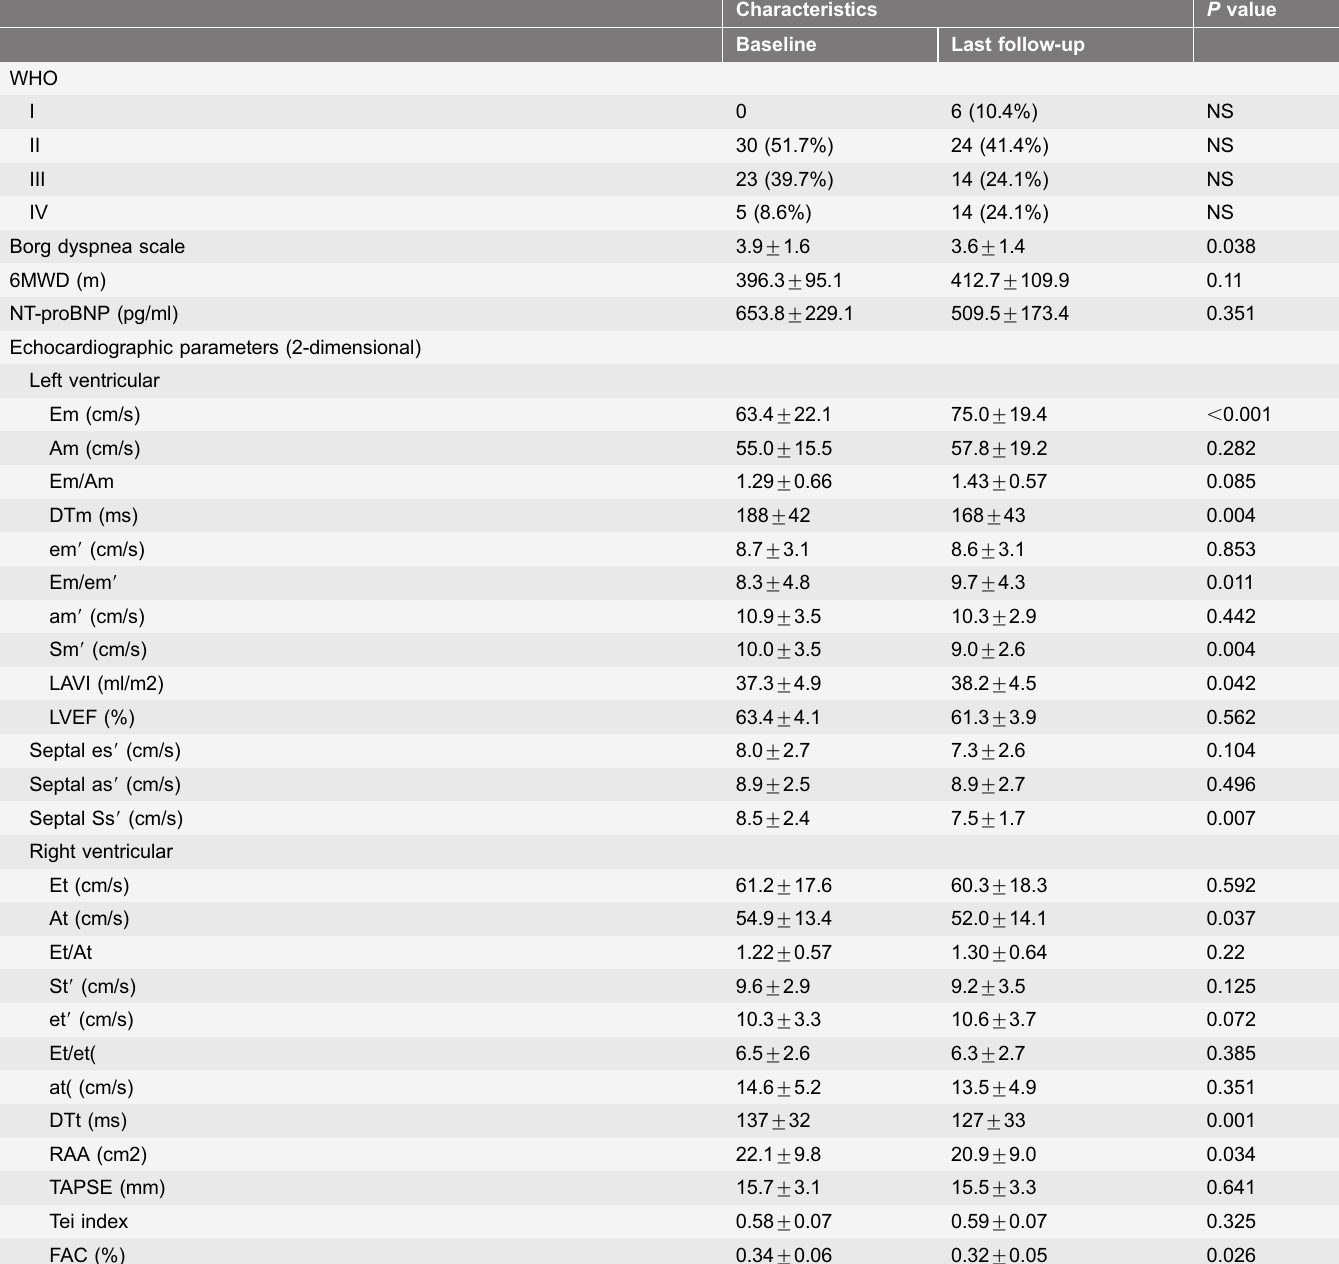
Table 2. Clinical and echocardiographic parameters in all patients at baseline and the last